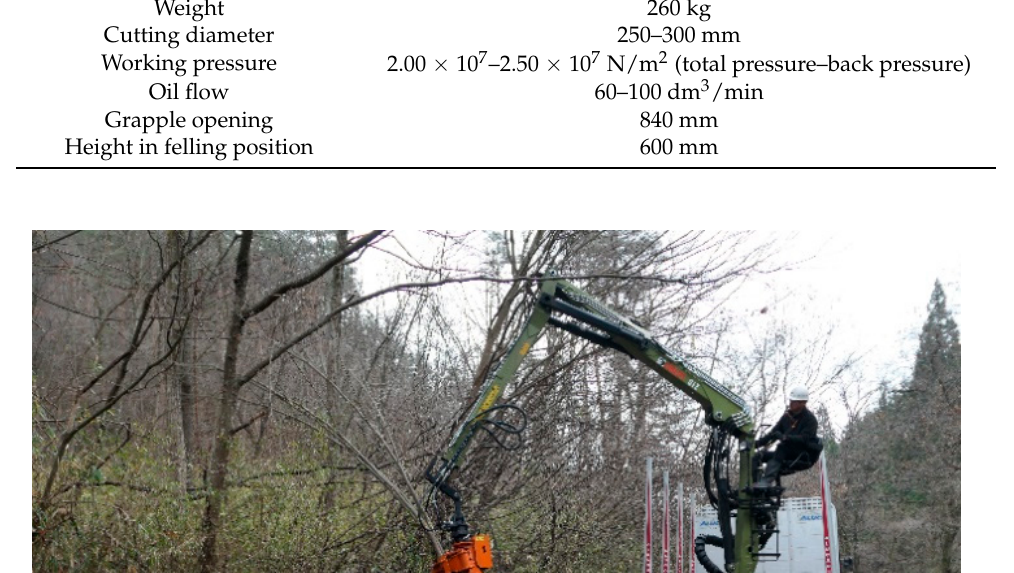
Table 2. Technical data of the ENERGY WOOD GRAPPLE 300, Biojack [28]. Item